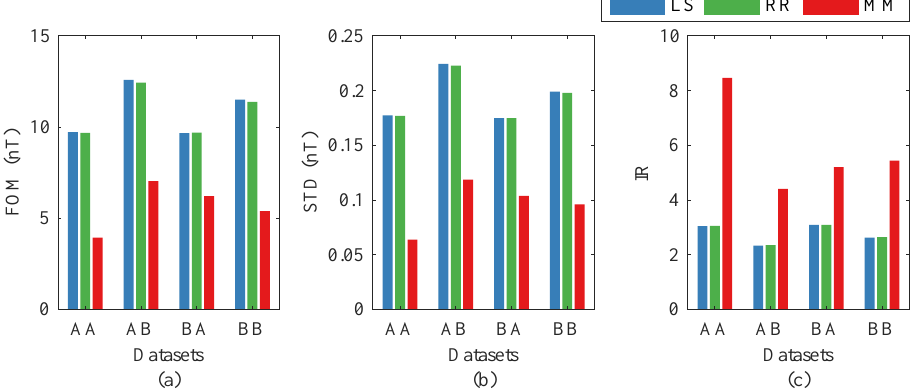
Figure 5. Comparisons between the three compensation methods: ( a ) figure-of-merit (FOM), ( b ) standard deviation (STD), and ( c ) improvement ratio (IR). LS—least squares; RR—ridge regression; MM—multimodel.